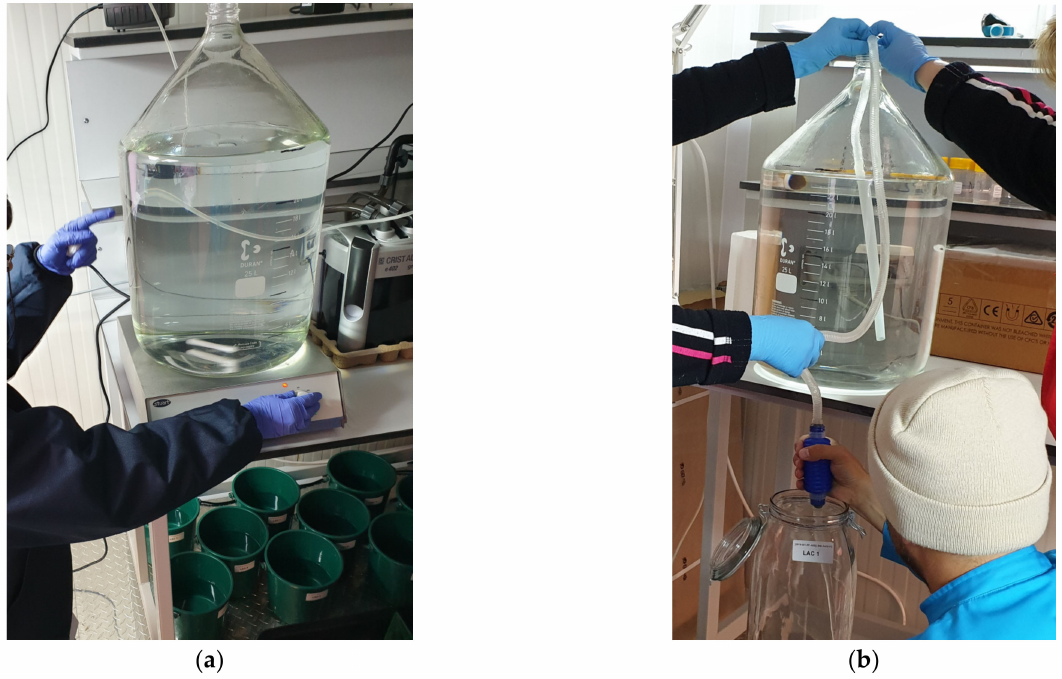
Figure 4. ( a ) Homogenization of the toxicant solution on a magnetic stirrer; ( b ) Distribution of the solution in the experimental jars (original